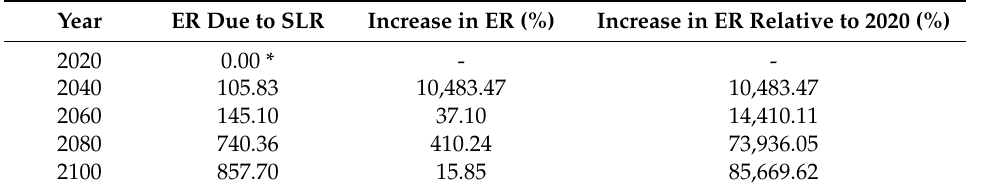
Table 7. Economic risks (ER) at Cairo due to Sea Level Rise (SLR).